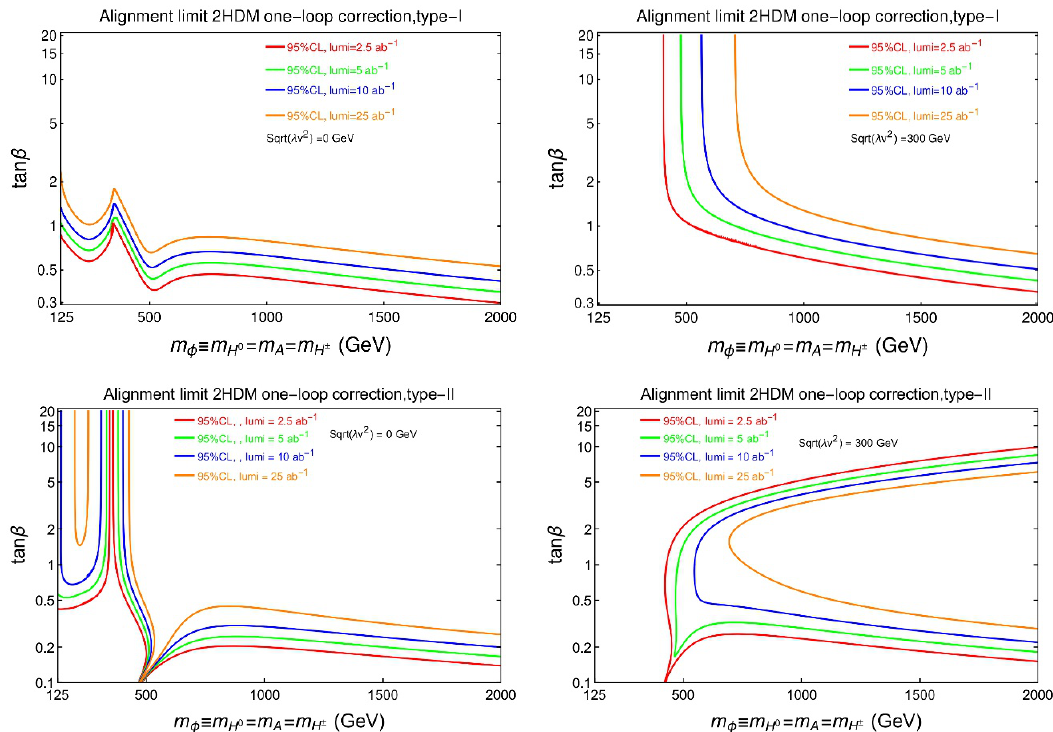
Figure 7 . 95% C.L. Higgs precision constraints on tan (cid:12) vs. m (cid:30) plane, assuming integrated luminosity of 2.5, 5, 10, and 25 ab (cid:0) 1 . Results for Type-I (top panels) and Type-II (bottom panels) p are presented, for two di(cid:11)erent benchmarks of (cid:21)v 2 = 0 (left panels) and 300 GeV (right panels).